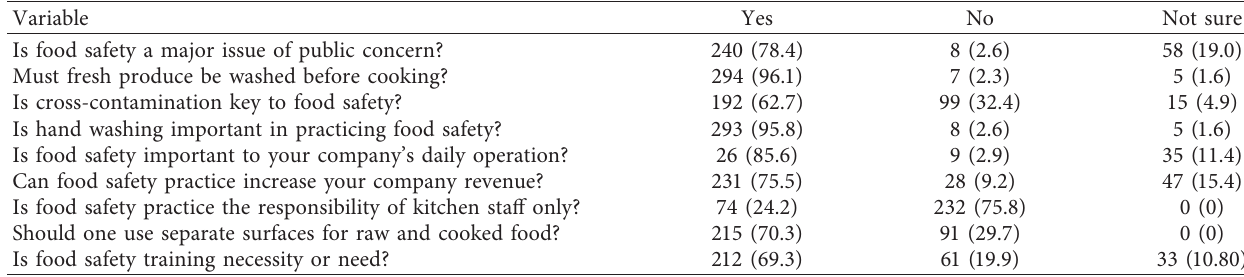
Table 3: Respondents’ attitudes to food safety.